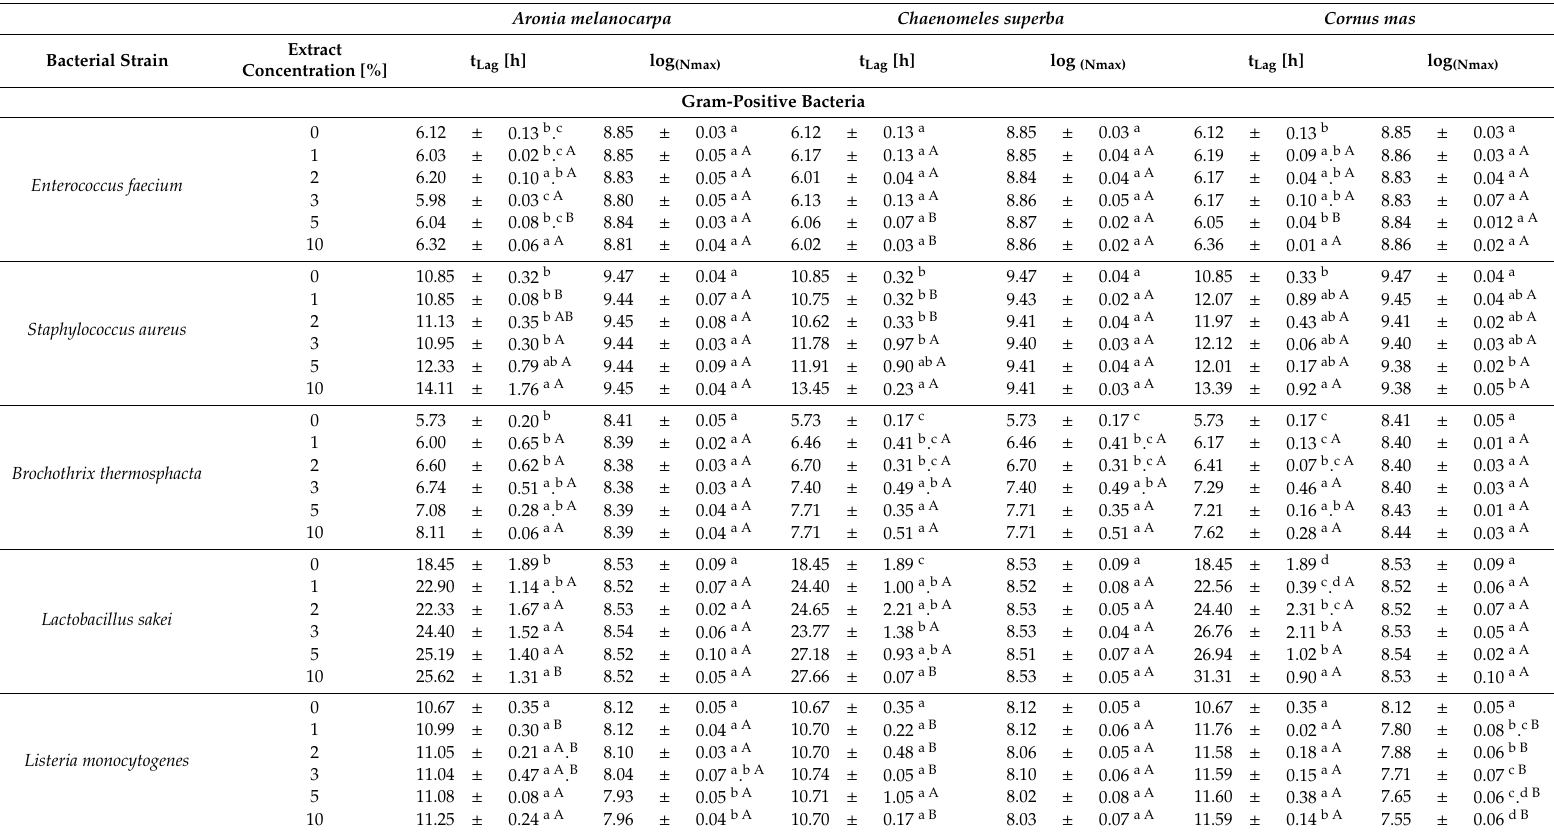
Table 4. E ff ect of leaf extracts on the lag time (t Lag ) and maximum population density (log (Nmax) ) of